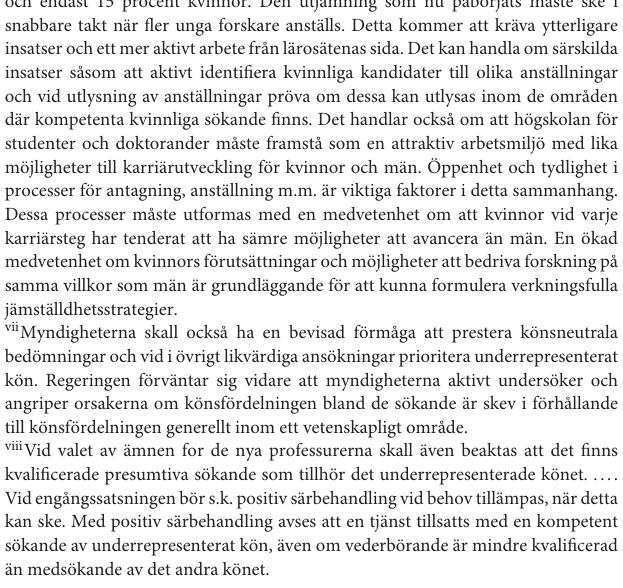
Frontiers in Communication |